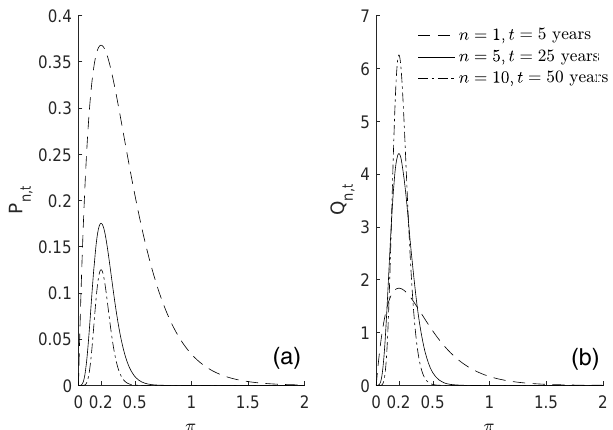
Figure 2. (a) Plot of P n,t against π , (b) plot of the normalized func- tion, Q n,t against π . The legend relates to both